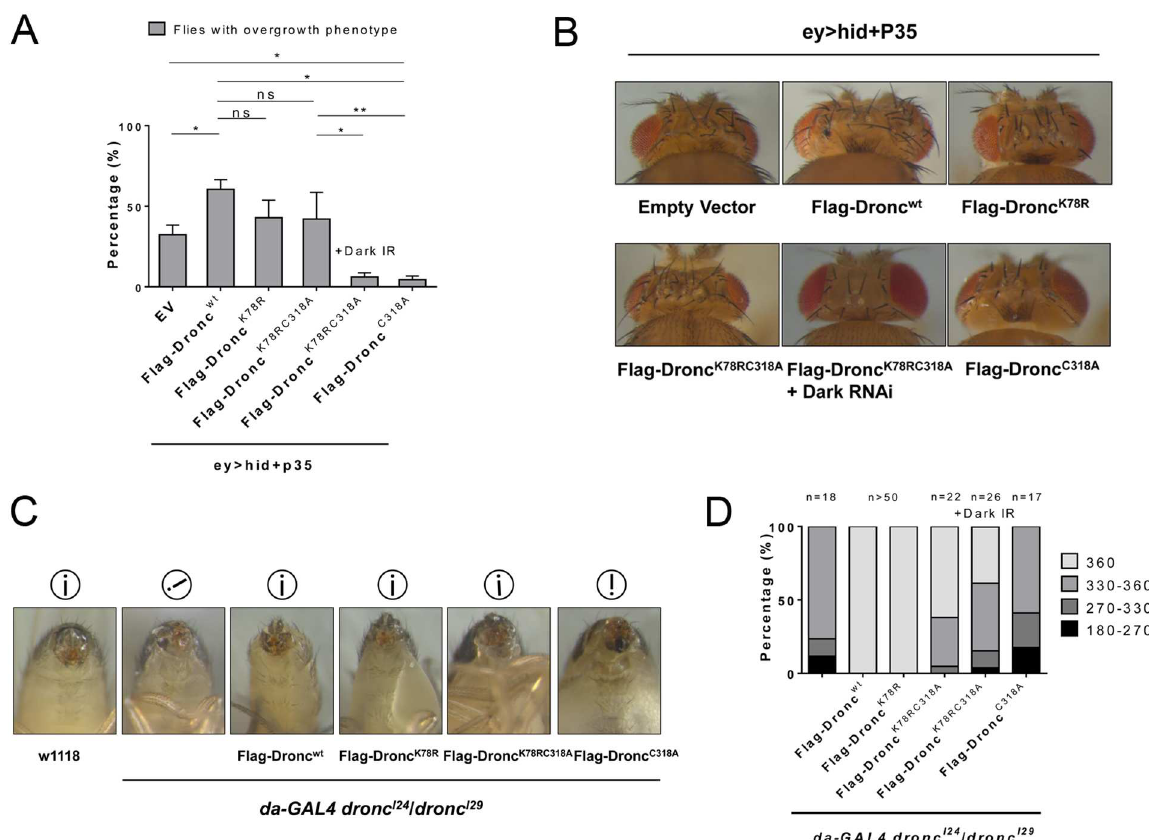
Fig 5. K78 ubiquitylation plays inhibitory roles for additional functions of Dronc. ( A ) Quantification of the enhanced head overgrowth phenotypeof ey > hid+p35 animalsexpressingthe indicated Flag-Dronc transgenes. Overgrowth is characterized by expandedhead cuticle with pattern duplications such as bristles and ocelli (see examplesin (B)). Flag-Dronc C318A acts in a dominant negative mannerin ey > hid+p35 background.Flag-Dronc K78RC318A phenotype in ey > hid + p35 background is dependenton Dark as observed by 94% suppression of the overgrowth phenotype when dark RNAi is expressed. (B) Representative headphenotypesof ey > hid+p35 animalsexpressingthe indicated Flag - Dronc transgenes. (C) Male genitaliarotation defect of dronc null mutants is fully suppressedby da > Flag-Dronc wt and da > Flag-Dronc K78R (100% of males display360˚ rotation) (quantifiedin D) and partially suppressedby da > Flag-Dronc K78RC318A (62% of males display360˚ rotation). da > Flag - Dronc C318A failed to suppressthis phenotype. The i surroundedby a circle indicatesthe relative orientation of the male genitalia in the depicted animals(i = wild-type). The suppression by da > Flag-Dronc K78RC318A is partially reverted (38% of full rotation) when Dark RNAi is expressed(quantifiedin B). (D) Quantificationof male genitaliarotation defect phenotype in dronc null mutants, expressingthe indicated Flag-Dronc transgenes. For quantifications, the student’s t-test was used. Error bars are SD. * P < 0.05; ** P < 0.01; ns—not significant.